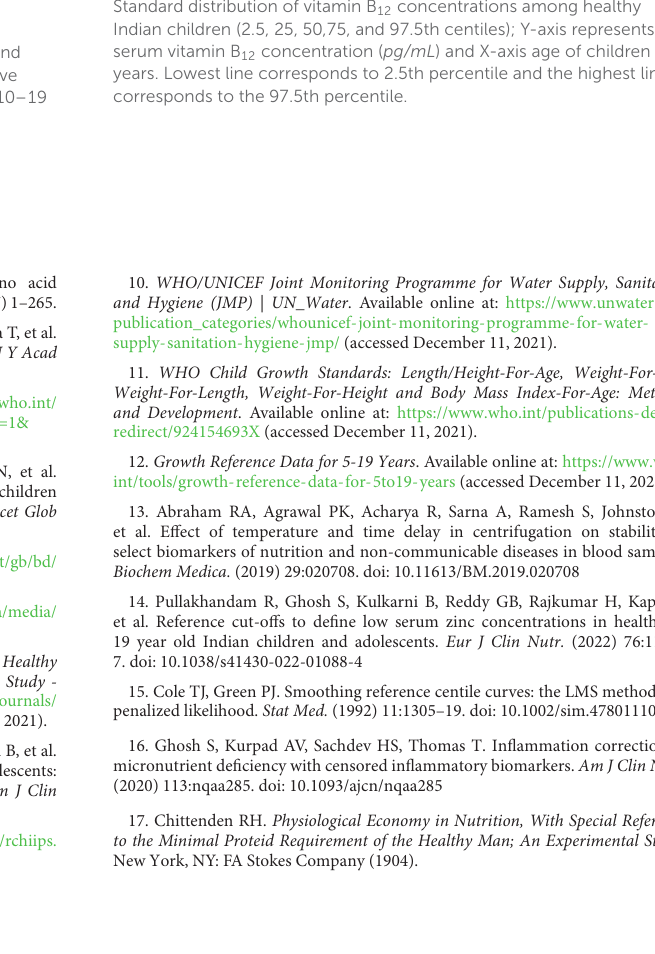
SUPPLEMENTARYFIGURE5 The direction of association between serum vitamin B 12 and factors used for extraction of healthy subsample of Comprehensive National Nutrition Survey across three age groups (1–4 y, 5–9 y, 10–19 y). HAZ, WAZ, WHZ and BAZ are abbreviations for height-for-age, weight-for-age, weight-for-height and BMI-for-age Z scores based on WHO growth standards. SUPPLEMENTARYFIGURE6 (A) Three randomly simulated sample data with three different ranges for an arbitrary variable. (B,C) Sampling distribution of mean and standard deviation of the random subset of upper 1/3 range of the arbitrary variable. SUPPLEMENTARYFIGURE7 Standard distribution of erythrocyte folate concentrations among healthy Indian children (2.5, 25, 50,75, and 97.5th centiles); Y-axis represents the erythrocyte folate concentration ( ng/mL ) and X-axis age of children in years. Lowest line corresponds to 2.5th percentile and the highest line corresponds to the 97.5th percentile. SUPPLEMENTARYFIGURE8 Standard distribution of vitamin B 12 concentrations among healthy Indian children (2.5, 25, 50,75, and 97.5th centiles); Y-axis represents serum vitamin B 12 concentration ( pg/mL ) and X-axis age of children in years. Lowest line corresponds to 2.5th percentile and the highest line corresponds to the 97.5th